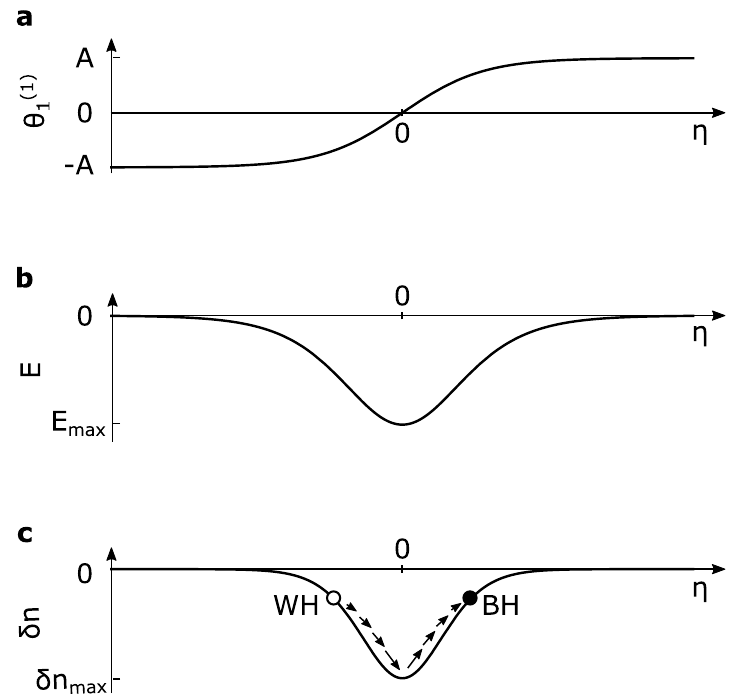
Figure 2. Sketch of ( a ) the phase soliton with the amplitude A , ( b ) the electric field with the amplitude (cid:31) / 2 ed ) A 2 √ E max Q / 2 P u , and ( c ) the cavity formed by the single dark soliton with the amplitude δ n max . ( = − | | The filled circle and open circle represent the horizon of the black hole and white hole, respectively. The size of arrows representing the velocity of the probe pulse varies in